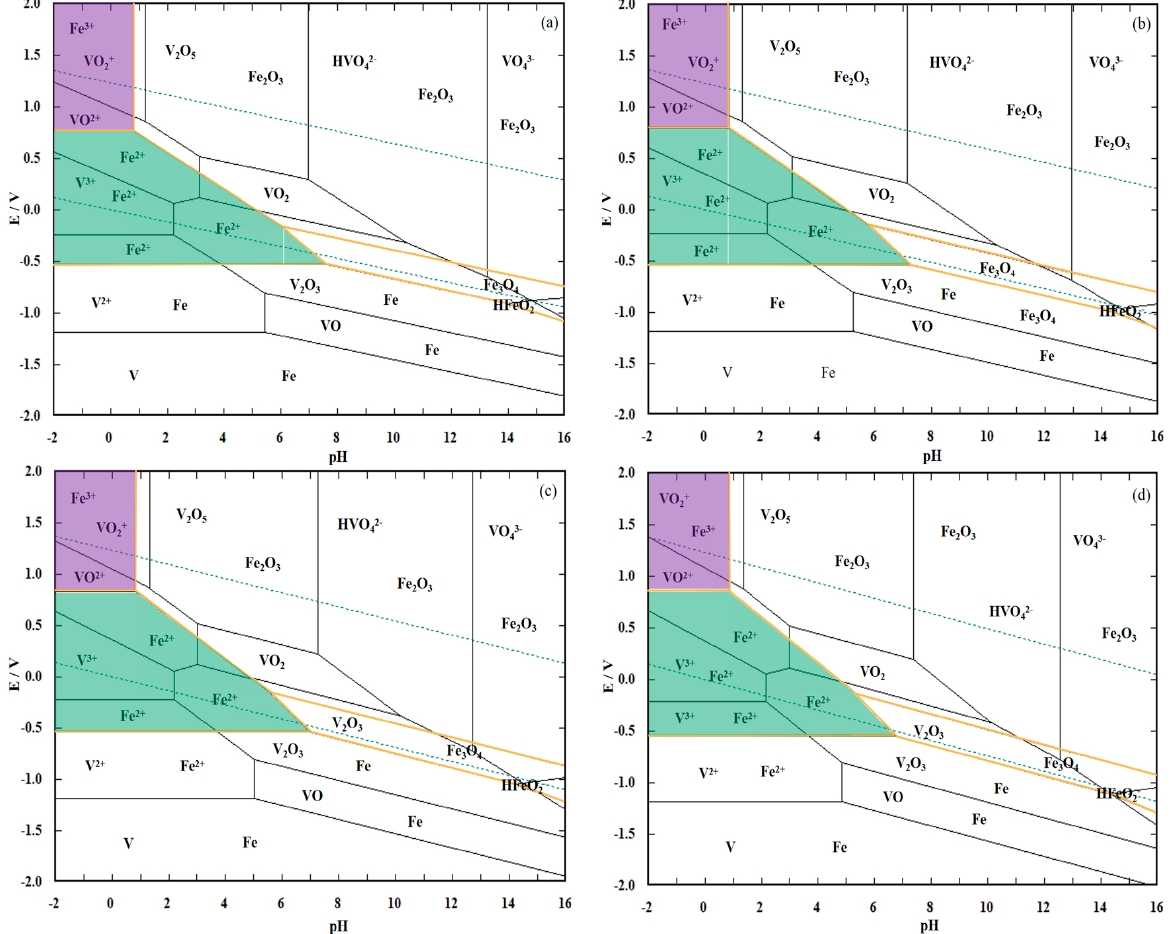
Figure 2. E-pH diagram of the V-Fe-H 2 O system at different temperatures ( a ) 25 ◦ C, ( b ) 50 ◦ C, ( c ) 75 ◦ C and ( d ) 100 ◦ C in the standard state.